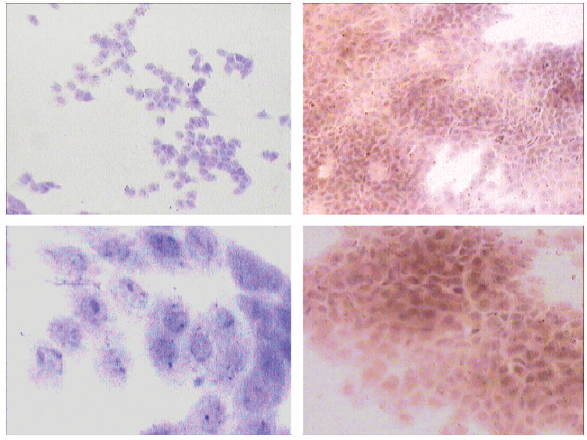
Figure 2 - HLA-DR expression. On the left: images of the travatan + timolol group pre-treatment, with cells negative for HLA. On the right: the same group after treatment, at 100 6 (on the top) and 400 6 (on the bottom) magnification, respectively.